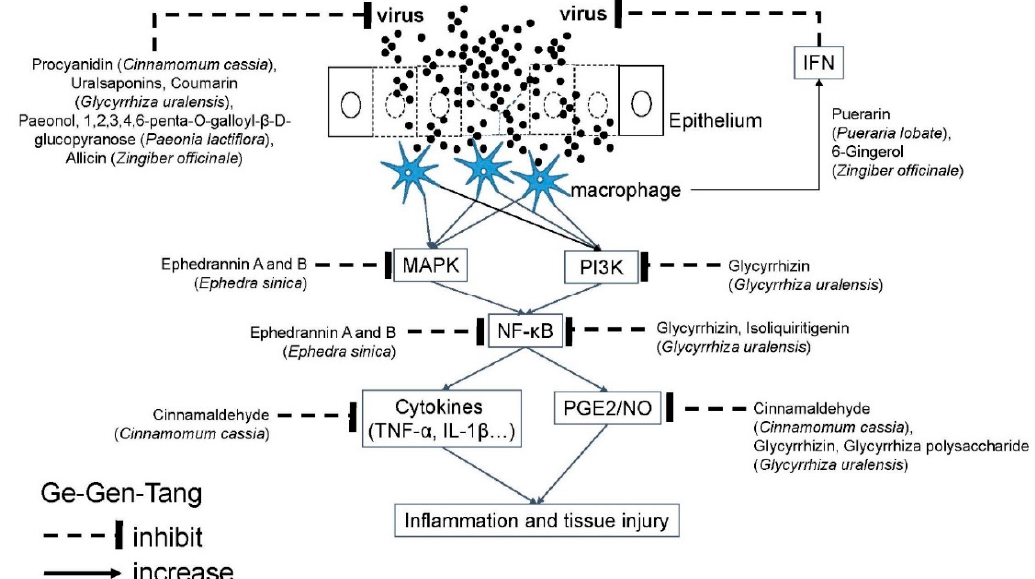
Figure 2. Molecular mechanism of Ge-Gen-Tang against airway viral infections. Airway viruses infect the epithelium to cause tissue injury. Ge-Gen-Tang contains several active molecules to inhibit viral replication and signal transduction of inflammatory response. Akt: Serine / threonine protein kinase B (PKB); COX: Cyclooxygenase; ERK: Extracellular signal-regulated kinase; IL: Interleukin; iNOS: inducible Nitric oxide synthases; JNK: c-Jun N-terminal kinases; MAPK: Mitogen-activated protein kinase; NF- κ B: Nuclear factor-kappa B; NO: Nitric oxide; PG: Prostaglandin; PI3K: Phosphoinositide 3-kinase; PMN: Polymorphonuclear neutrophils; TNF: Tumor necrotic factor.